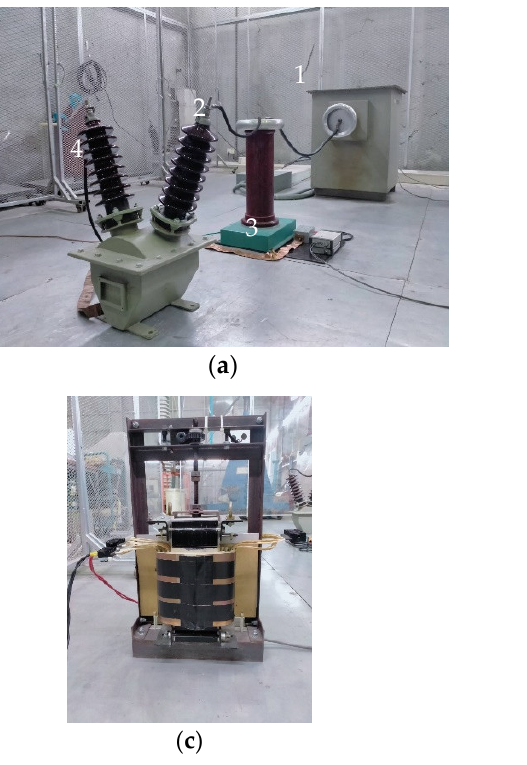
Figure 18. Experimental setup of the HV and PD tests with a test object: ( a ) Equipment in the actual HV laboratory composed of (1) HV testing transformer, (2) coupling capacitor, (3) measuring impedance, and (4) VT under test. ( b ) Additional capacitor. ( c ) Adjustable inductor. ( d ) Developed converter.